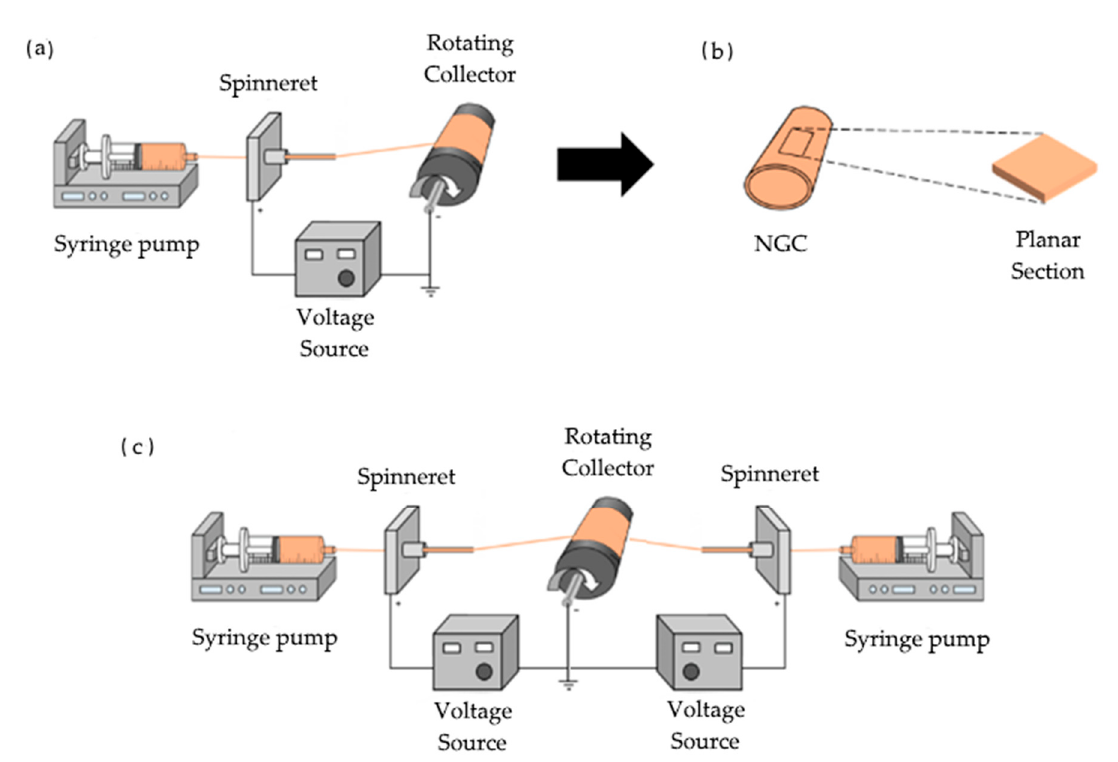
Figure 2. ( a ) NGCs were fabricated using electrospinning; ( b ) guides were cut into planar sections of length area of 8.5 mm × 8.5 mm; ( c ) double-spinneret electrospinning set-up for gelatin–PEO guide fabrication.